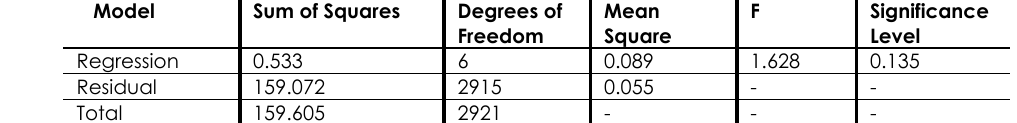
Table 12. Table of variance in the model established to determine whether there is a day effect on accidents.